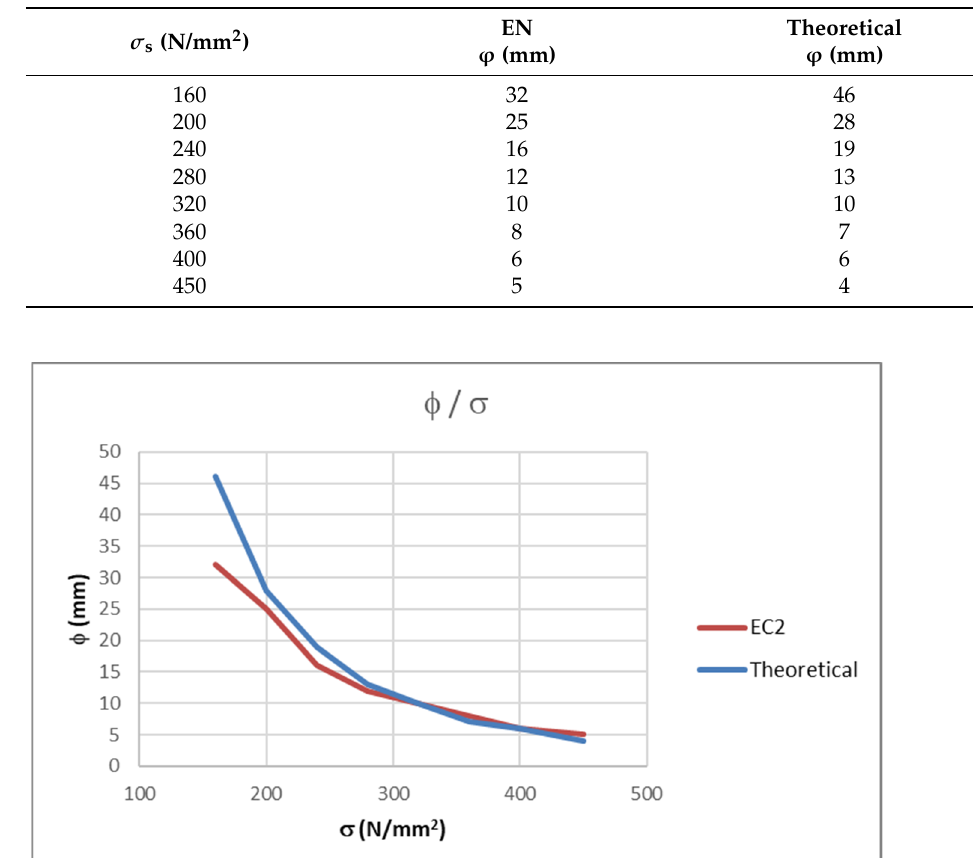
Figure 1. Comparison of values from [6] and theoretical values (Equation (9)).